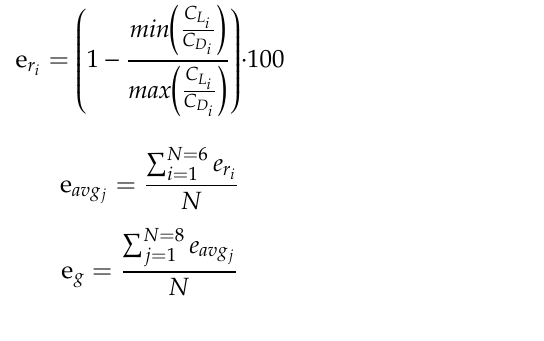
Table 1. Relative error (%) for each case. The last row shows average errors for each hGF.